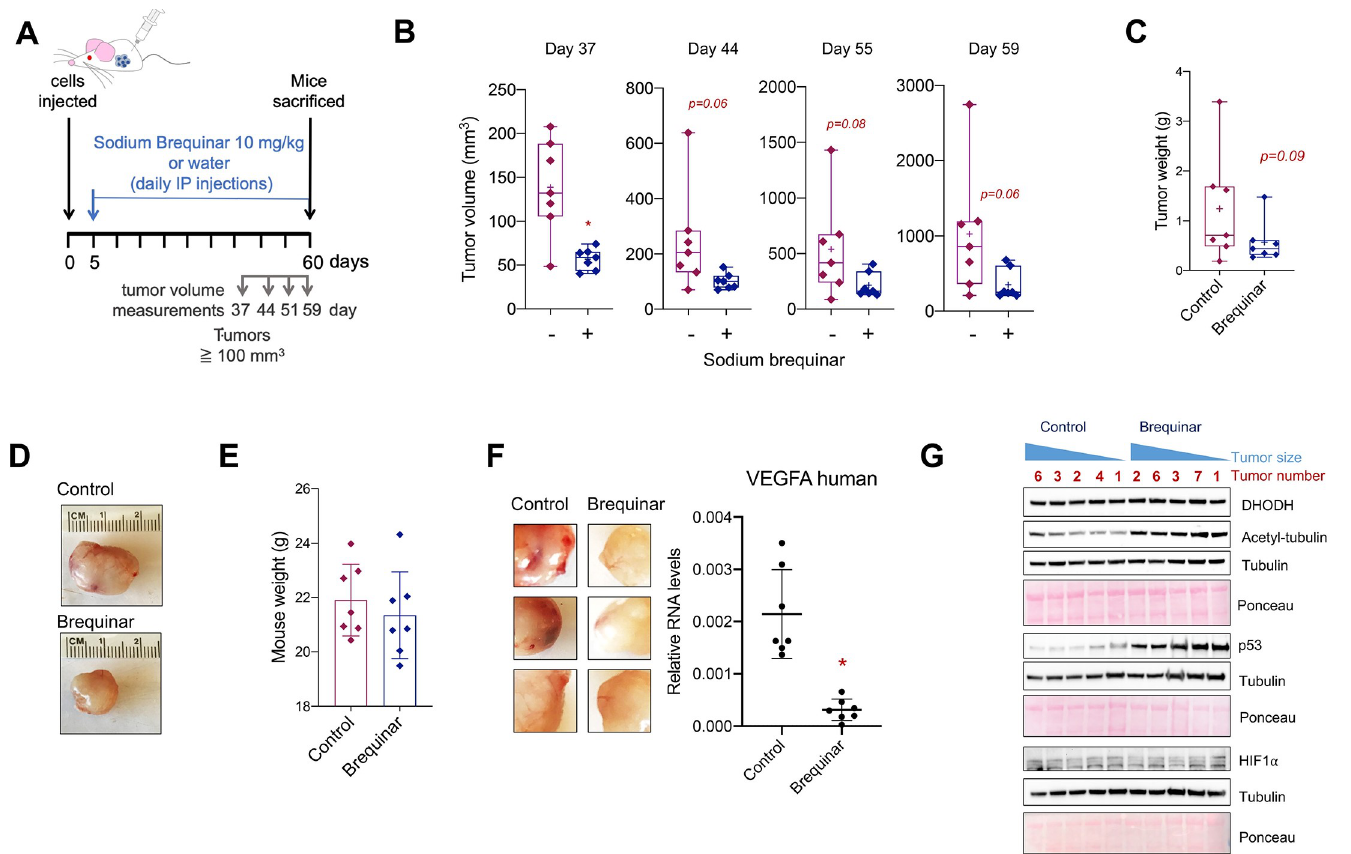
Fig 3. Blocking DHODH with brequinar reduced reduces glioblastoma tumor xenografts growth in vivo . (A) Representation of the subcutaneous xenograft experiment using LN229 cells. Mice were treated with 10 mg/kg brequinar with daily intraperitoneal injections (IP). (B) Tumor volume measurements of LN229 xenografts once the tumors reached 100 mm 3 . (C) Tumor weight of LN229 xenografts at day 60 (end of experiment). See also Supplementary S5B and S5C Fig. (D) Representative xenograft tumors from control and brequinar-treated mice. See also Supplementary S5B Fig. (E) Mouse weights at day 60 before the tumors were harvested. (F) Three representative control and brequinar-treated LN229 xenografts tumors showing increased blood vascularity in the control group (left panel) and qPCR for VEGFA in the LN229 xenografts. (G) Western blot of 5 control and brequinar-treated LN229 xenograft tumors for DHODH, p53, acetyl-tubulin, and HIF1 α . � indicates p-values ≦ 0.05. Numerical values for each of the experiments represented are available in S3 Data.